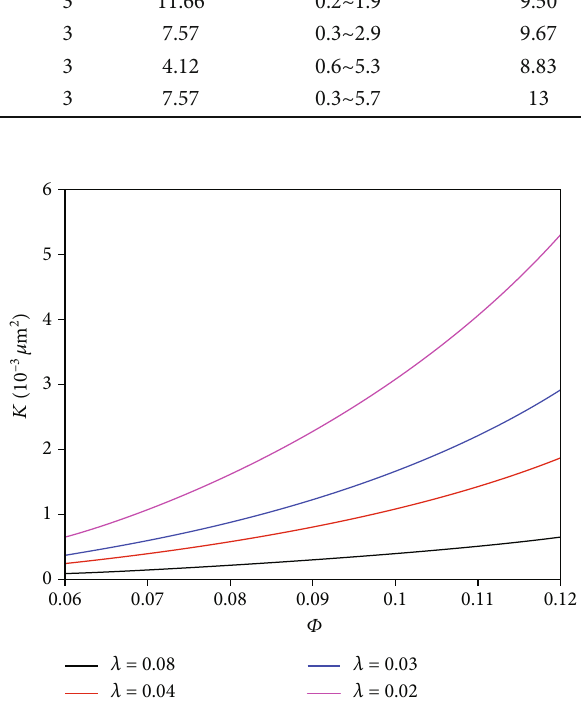
Figure 6: The relation between porosity and permeability under di ff erent pore radius